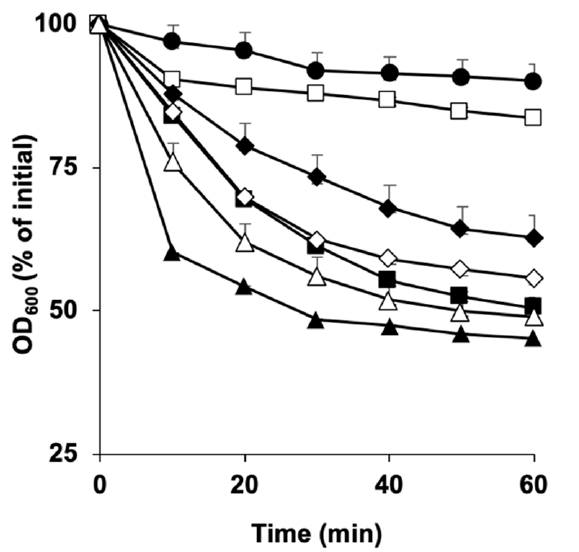
Figure 3. Induction of C. perfringens SM101 spore germination by divalent cations. Heat-activated SM101 spores were incubated in 25 mM Tris-HCl buffer (pH 6.0) containing 100 mM KCl (pH 6.0) (filled triangles), 50 mM CaCl 2 (pH 6.0) (open triangles), 50 mM MnCl 2 (pH 6.0) (filled squares), 50 mM MgCl 2 (pH 6.0) (open diamonds), 50 mM MgSO 4 (pH 6.0) (filled diamonds), or 50 mM ZnCl 2 (pH 6.0) (open squares) and in 25 mM Tris-HC buffer (pH 6.0) alone (filled circles). The OD 600 was measured at various time points and used to calculate percent germination. Error bars are the standard deviations from the means of at least duplicate experiments with three independent spore preparations.